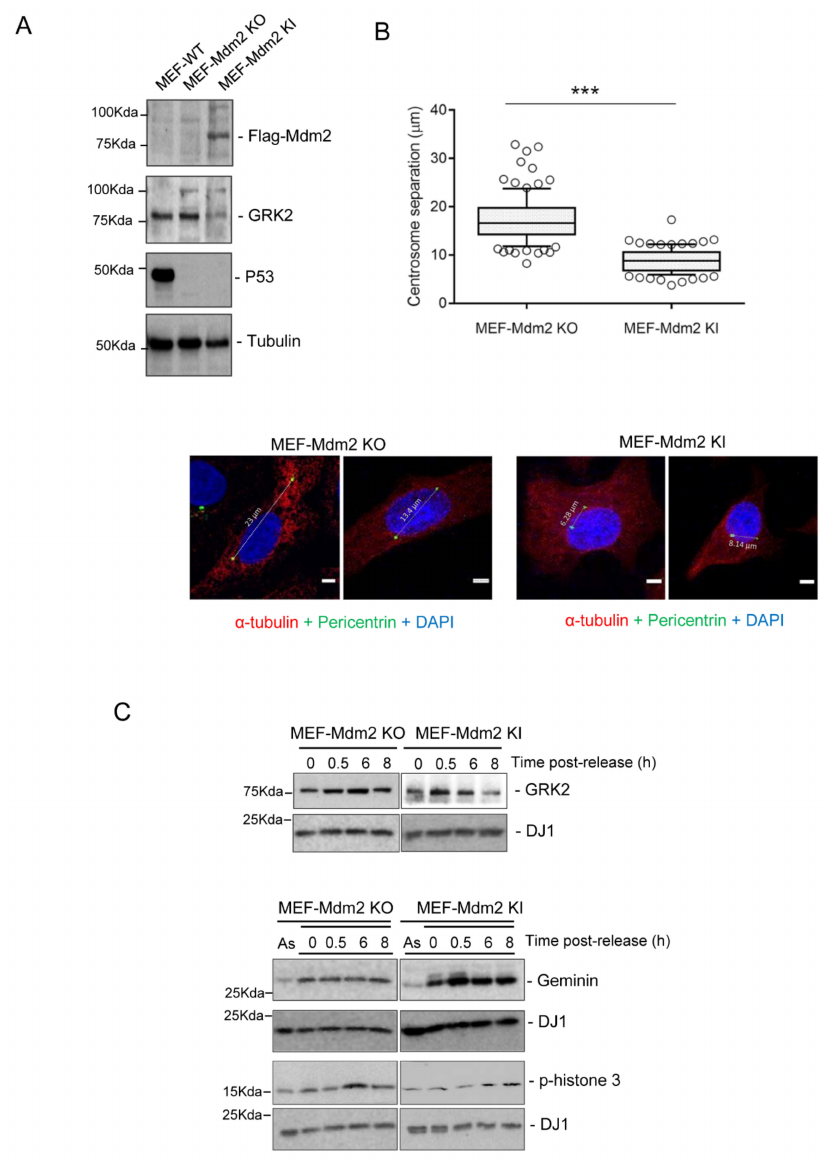
Figure 3. Mdm2 restrains centrosome separation in the G2 phase in parallel to GRK2 downmodulation. ( A ) GRK2 is downregulated by Mdm2 in MEF cells. Ligase activity was restored in p53 and Mdm2 double-knockout MEFs (Mdm2 KO) with lentiviral constructs of Flag-tagged human Mdm2 to generate MEF Mdm2 KI cells. Primary MEFs obtained from C57BL6 mice were used as wild-type control cells. RIPA lysates from exponentially growing cells were analyzed by immunoblot using specific anti-Flag tag, anti-GRK2 and anti-p53 antibodies. Tubulin was used as a control of protein loading. A representative blot is shown. ( B ) Both Mdm2 KO and Mdm2 KI MEF cells were synchronously released into the cell cycle for 6 h after G1/S arrest with a thymidine-aphidicolin double block. Cells were fixed and stained for interphase microtubules with anti- α -tubulin antibody (red), centrosomes with anti-pericentrin antibody (green) and DNA with DAPI (blue). Distances between the two centrosomes of cells were quantified in confocal images. Data are mean ± SEM from two independent experiments represented in box-and-whiskers plots: boxes show the upper and lower quartiles (25–75%) with a line at the mean, whiskers extend from the 10 to the 90 percentiles (mean: Mdm2 KO = 17.45 µ m, n = 106 cells; Mdm2 KI = 8.95 µ m, n = 100 cells). *** p < 0.001, two-tailed t -test. Representative cells for each condition are shown, scale bar 5 µ m. ( C ) Levels of geminin and pSer10-histone 3 confirm that Mdm2 KO and Mdm2 KI MEF cells display similar progression in the G2 after 6 h of post-release from G1/S arrest, as shown by the increase in pSer10-histone 3 in cells without band shift of geminin. Reintroduction of Mdm2 restores timely decay of GRK2 levels in the G2 phase. Immunoblots of RIPA cell lysates were probed with the indicated antibodies. Levels of DJ1 and actin confirm similar protein loading. Representative blots are shown. Detailed information about the Western blots can be found in Figure